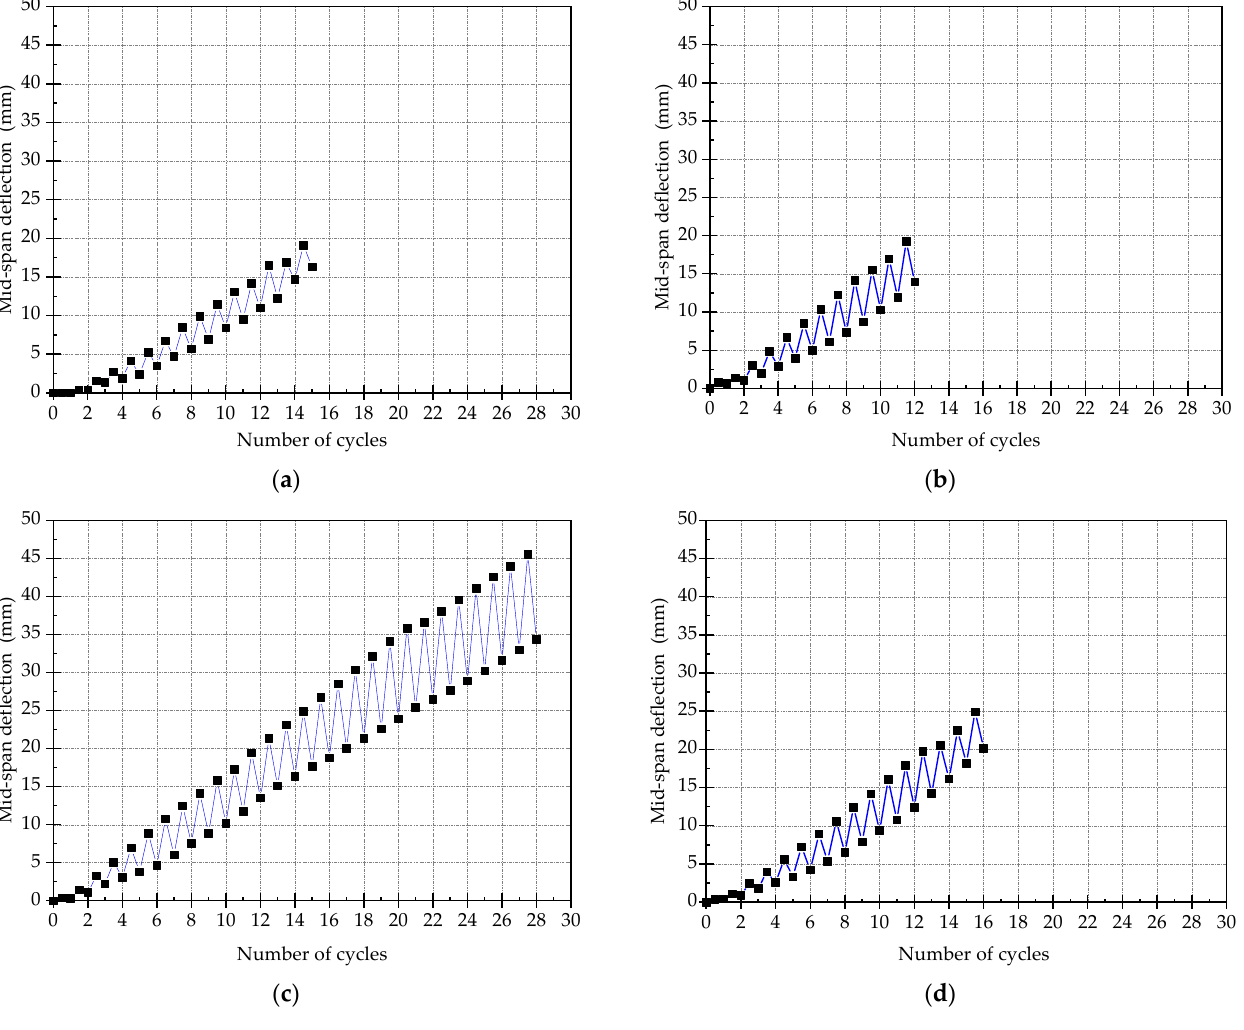
Figure 14. The curves of mid-span deflection. ( a ) SJ-1; ( b ) SJ-2; ( c ) SJ-3; ( d ) SJ-4.